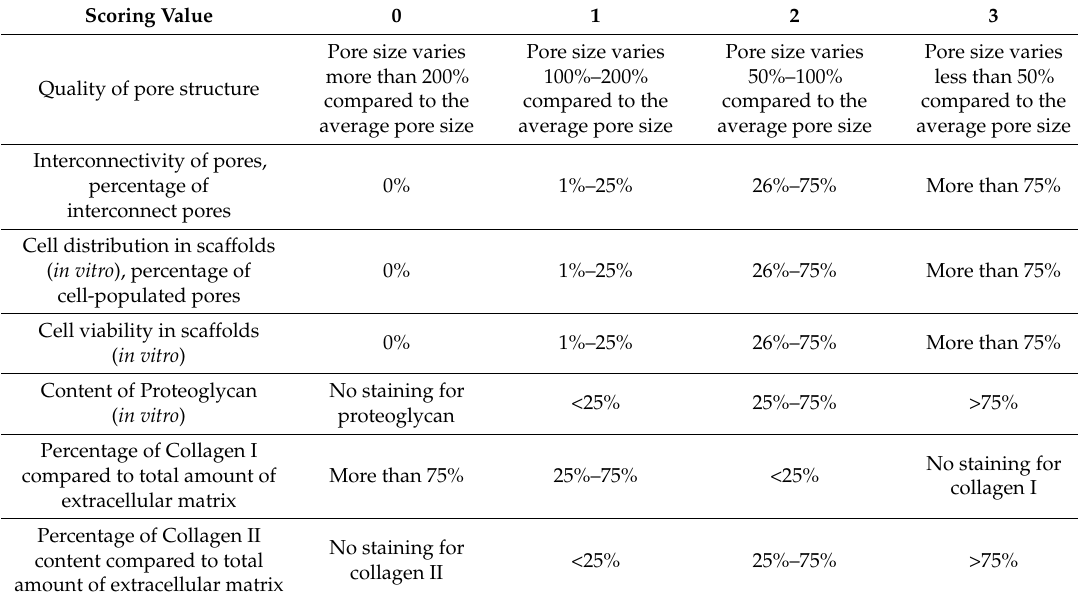
Table 1. Scoring system for analysis of biomaterials used for meniscal substitution or tissue engineering of the